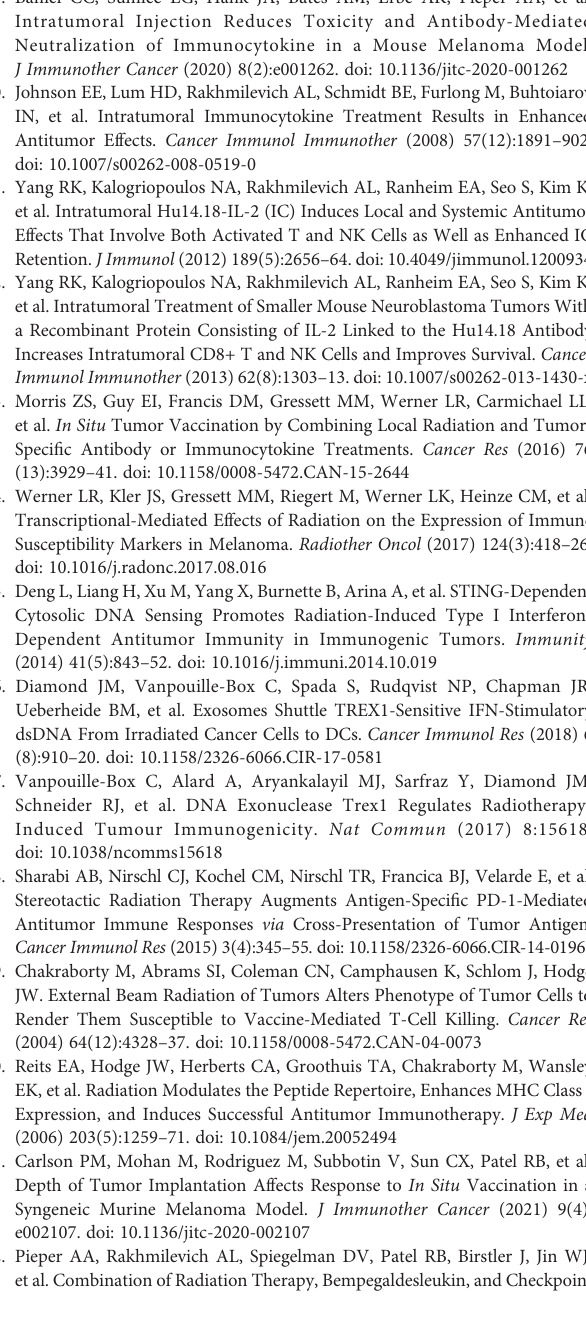
Supplementary Figure 5 | The frequency of Tregs per 100,000 cells in the TME ond.14andd.21followingtreatmentwithPBS(black),CpG+OX40 (red),RT(blue), and RT+CpG+OX40 (teal). Each symbol represents the TILs from one mouse. P values were calculated via two-way ANOVA. *P ≤ 0.05; **P ≤ 0.01; ***P ≤ 0.001; ****P ≤ 0.0001. Supplementary Figure 6 | The fl ow cytometry gating strategy used in FlowJo to quantify the IFN g expression levels of CD4+ and CD8+ T cells in the TDLNs and spleens of mice treated with PBS, CpG+OX40, RT, and RT+CpG+OX40 for Figures 6A, B